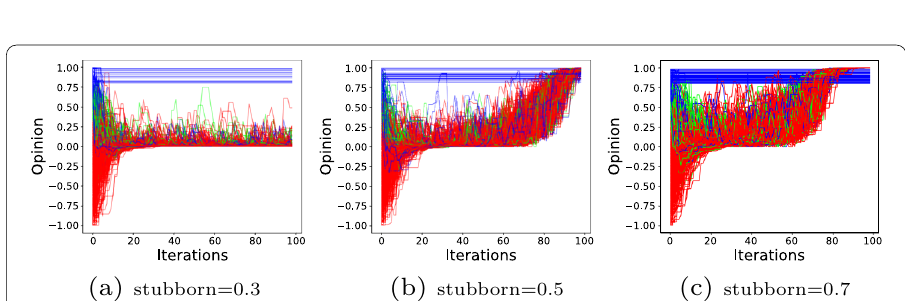
Fig. 6 Effect of the stubborn agents varying their percentage in the AWHK model with ǫ equal 0.85. The stubborn agents opinion is fixed to extreme positive opinion. Stubborn population opinion evolution lines are omitted. The stubborn presence leads to a more chaotic regime towards the stubborn agents’